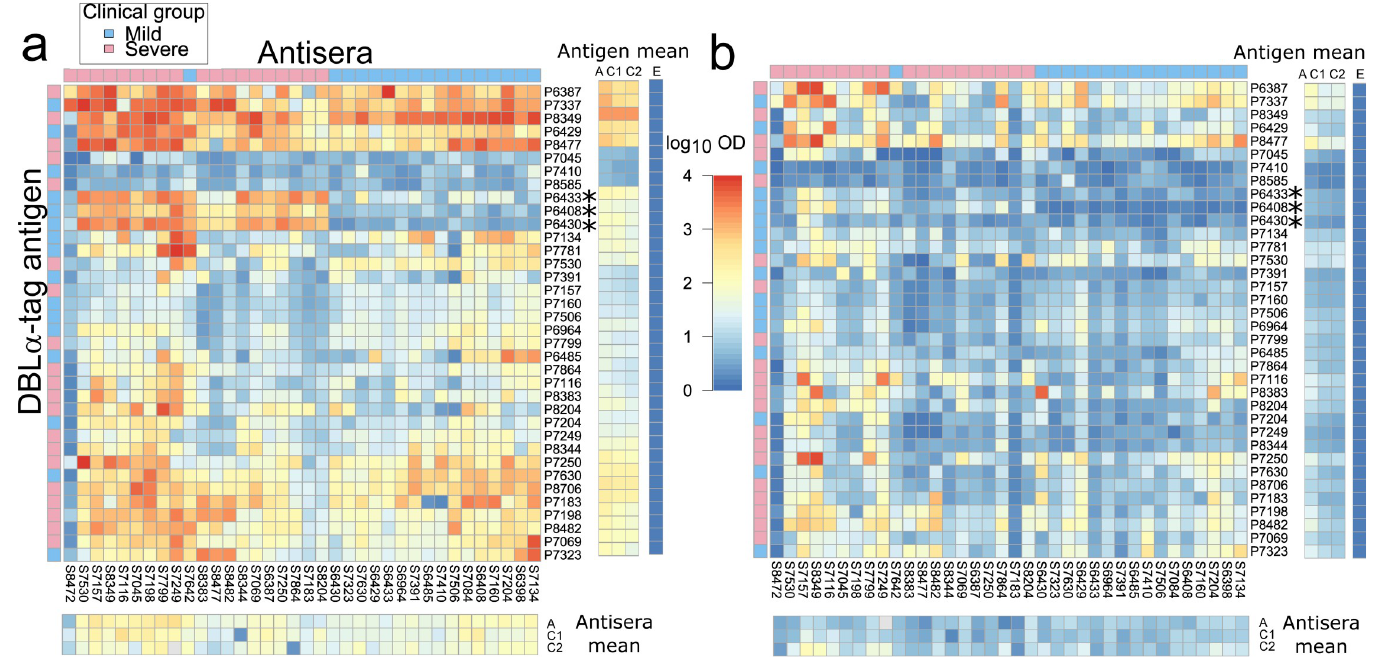
Fig 1. Sero-reactivity patterns of 36 plasma to 36 parasite DBL α -tag recombinant antigens. Square panels show strength of reactivity in log 10 OD units (colour bar in centre) of pairwise combinations of 36 plasma (‘antisera’, columns) and 36 DBL α -tag antigens (rows) at the acute stage of infection for IgG ( a ) and IgM ( b ). Colour bars above and to the left of the heatmaps indicate clinical group (legend at top left). Right side panels show the mean strength of reactivity for the antisera or DBL α -tag antigen at the acute (A) and convalescent stages of the infection (C1 and C2, see S1 Fig). Corresponding means for plasma from eight Europeans are shown in the colour bar marked ‘E’: their 95% confidence intervals were below 0.20 log 10 OD units for both IgG and IgM. Antisera and antigen labels indicate the patient number from which parasite material (isolate) and plasma were sourced, prefixed with S and P, respectively. Asterisks mark ‘indicator’ antigens, i.e., antigens that drove the topology of serological